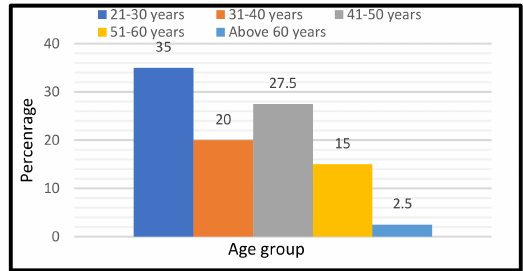
Figure 9. Age distribution of the vegetable seed farmers.